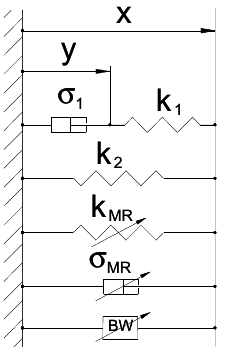
Figure 18. MRE visco-elastic model.